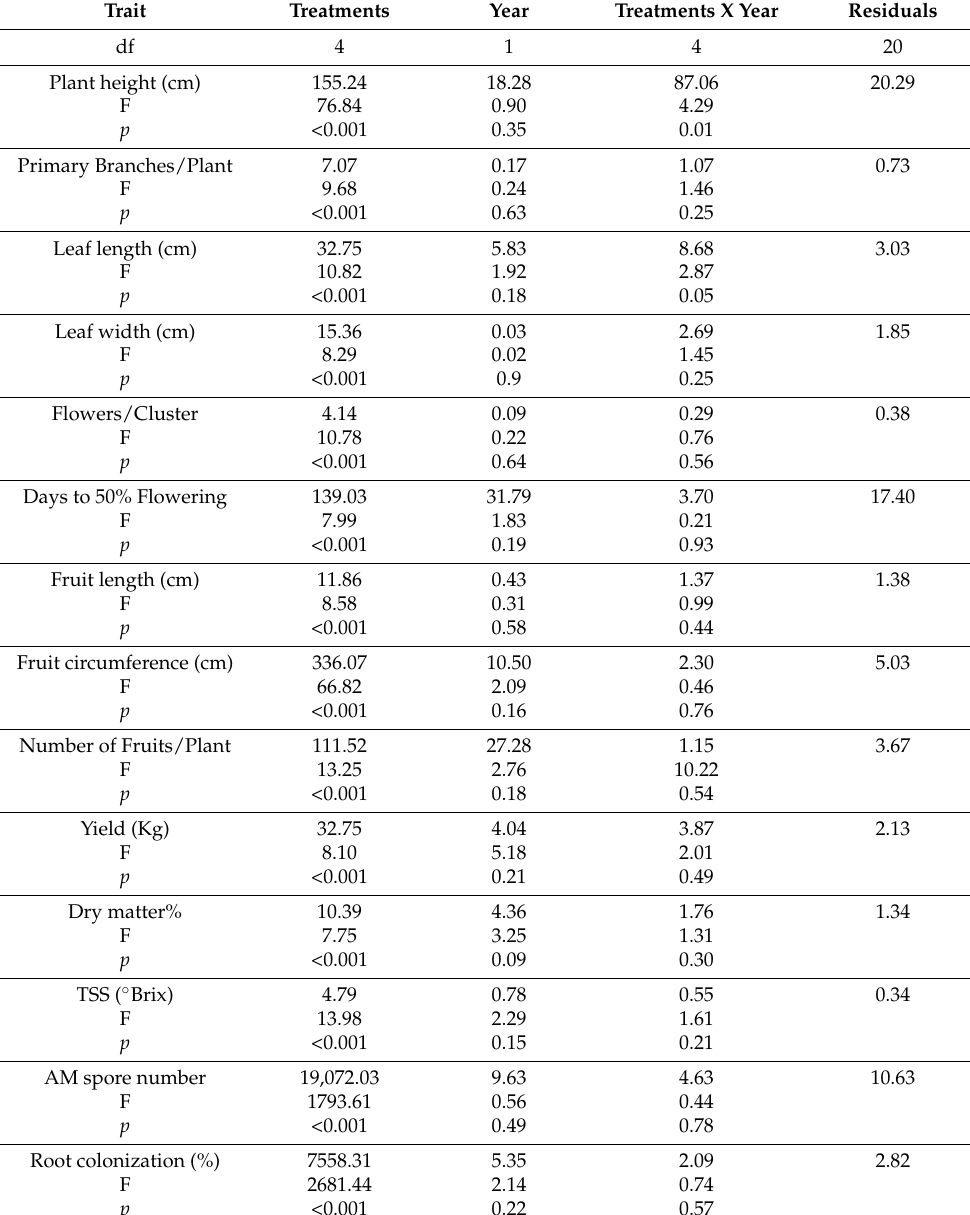
(Table 1). The treatment effects over the 2 years were significant only for two traits, plant height and leaf length. The effects of the mycorrhizal fungus R. irregularis and/or the nitrogen-fixing bacterium A. chroococum and/or chemical fertilizer on the growth and development of eggplant were investigated (Table 2). Data indicated that microbial fertilizers with reduced rates of chemical fertilization (75% of the conventional application) (75%CF + RI + AC) produced eggplant biomass and growth better than those obtained using the 100% or 75% of the chemical fertilizer alone. In addition, the dual combination 75%CF + RI and 75%CF + AC positively affected the measured traits (Table 2). Table 1. Variance analysis of the effects of different treatments on morphological and biochemical traits of eggplant. Trait